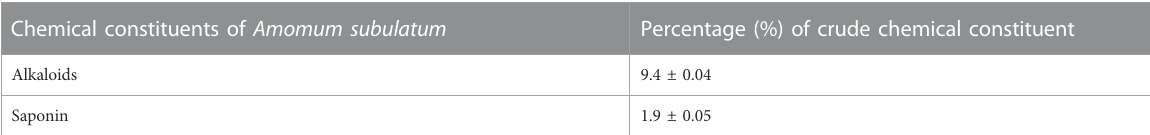
TABLE 2 Quantitative estimation of the percentage crude chemical constituents in Amomum subulatum seeds extracts. Chemical constituents of Amomum